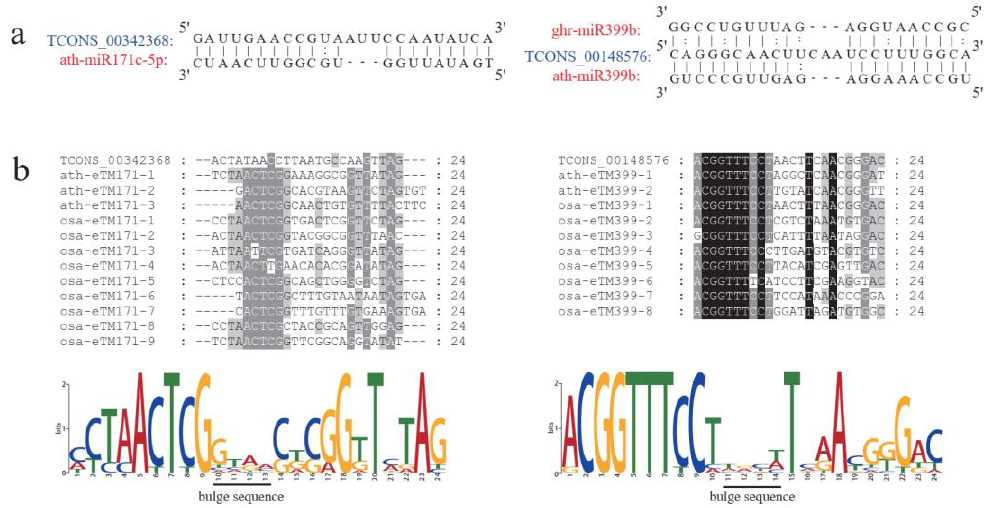
Int. J. Mol. Sci. 2019 , 20 , x FOR PEER REVIEW